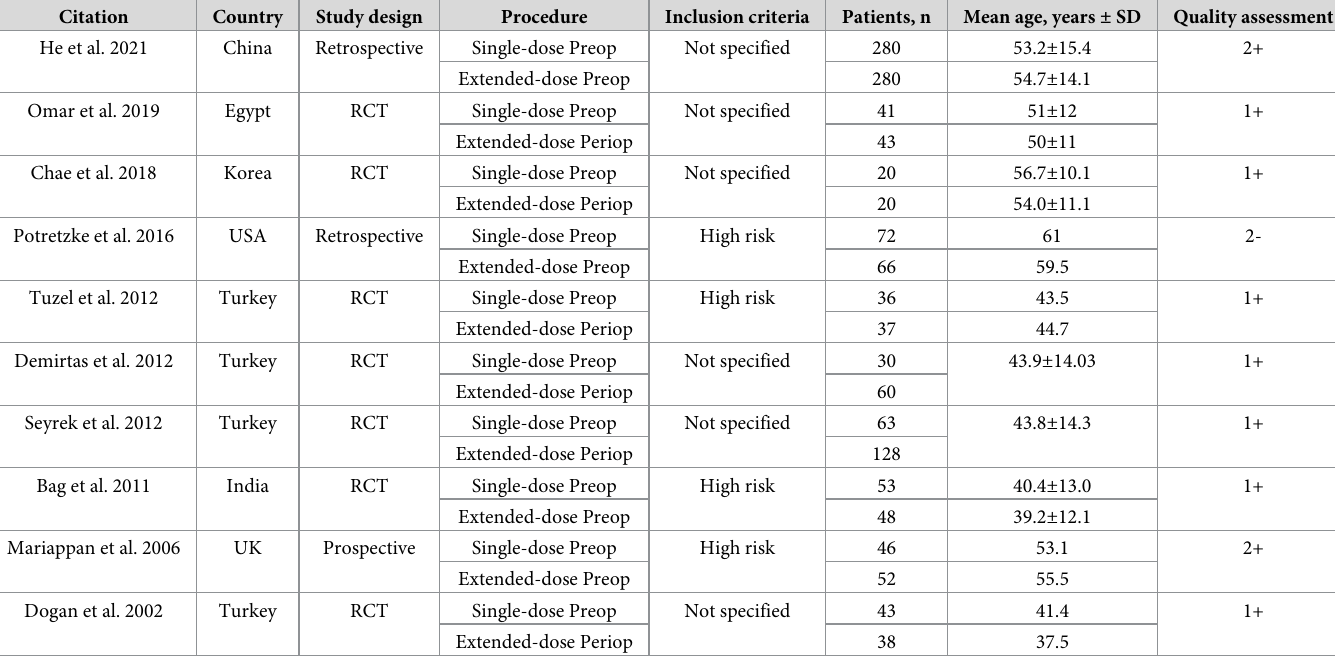
Table 1. Characteristics of included